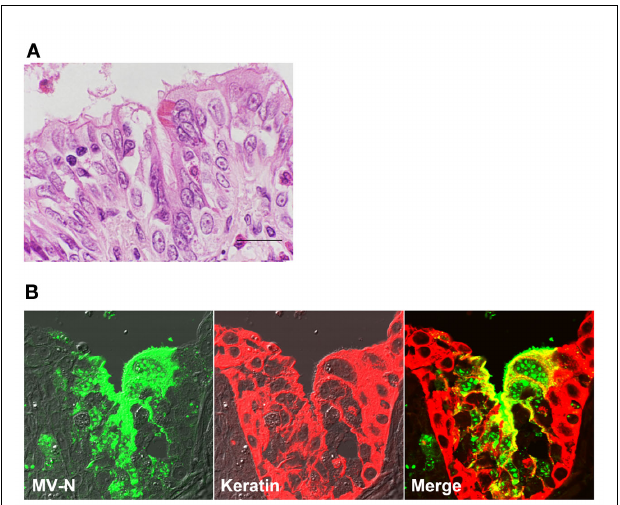
FIGURE 1 | Measles virus antigen and histopathological changes in bronchiolar epithelial cells. At 11 days post-infection, a cynomolgus monkey experimentally infected with wt MV IC323 strain was subjected to the histopathological examination. (A) Hematoxylin and eosin staining. Multinucleated cell were seen in the epithelial layer of the bronchiole with inflammatory infiltration of eosinophils and lymphocytes.The multinucleated cells contain eosinophilic intranuclear inclusions. Scale bar indicates 20 μ m. (B) Immunohistochemical double staining for the N protein of MV (left, green) and keratin (center, red). Multinucleated epithelial giant cells showing positive staining for the N protein are present in the bronchiole (right, yellow in merged images). Accumulation of N proteins is detected on the apical surface of ciliated epithelial cells.